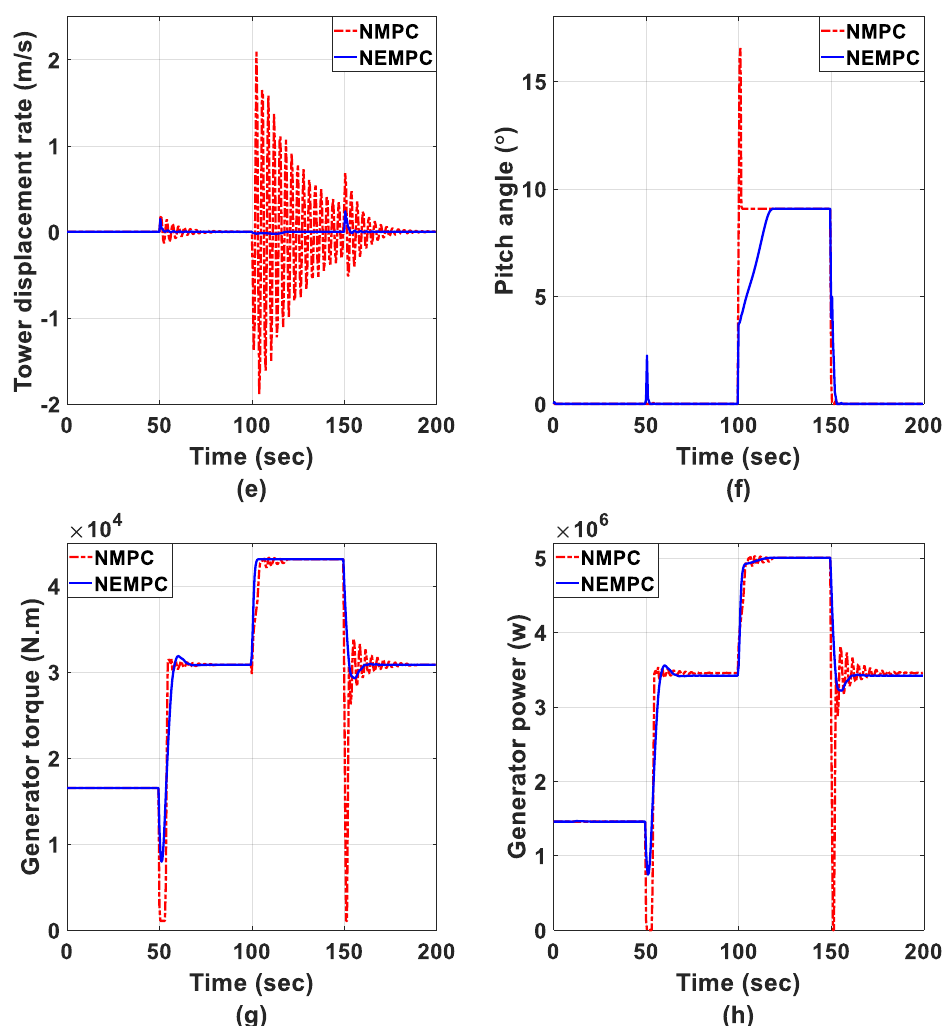
Figure 6. ( a ) Generator speed; ( b ) Rotor speed; ( c ) Shaft torsional angle; ( d ) Tower displacement; ( e ) Tower displacement rate; ( f ) Pitch angle; ( g ) Generator torque; ( h ) Generator power.